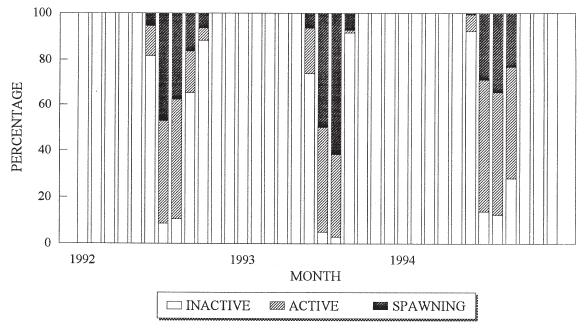
F IG . 7. – Monthly evolution of the percentages of individuals in the different maturity stages (at rest(A+E), active (B+C) and spawning (D)) for females of Aristeus antennatus